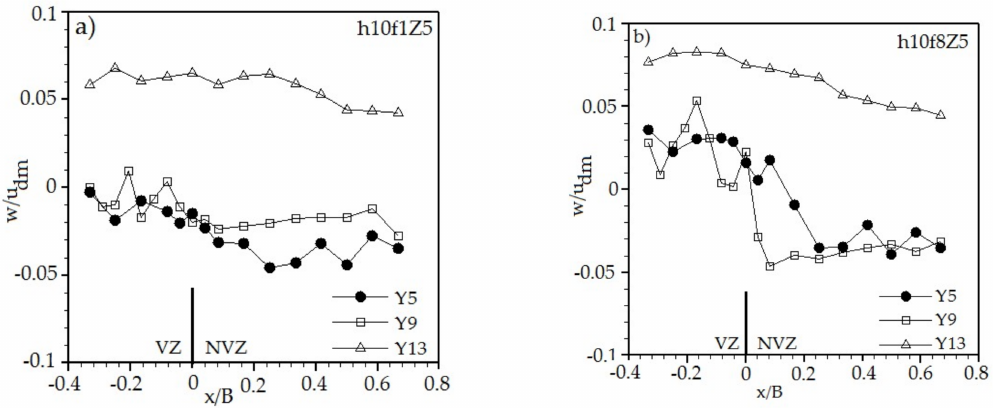
Figure 15. Non-dimensional vertical velocity distributions along the streamwise direction at z / h v = 1 for h v = 0.1 m; ( a ) φ = 0.01; ( b ) φ = 0.08.